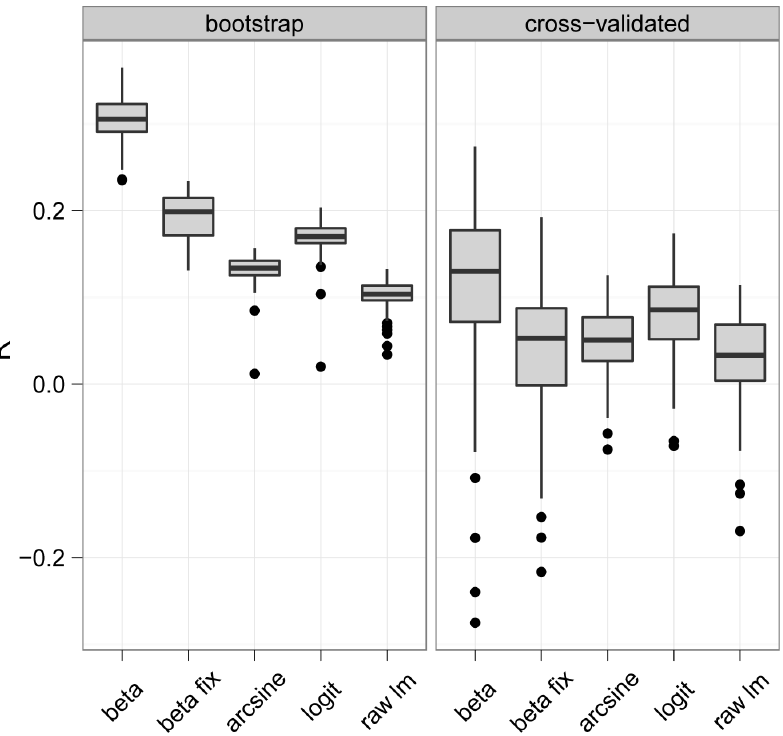
Figure 4. Boxplots of R 2 values. Analysis of the NLA Data. The figure contains boxplots of R 2 values obtained from the 100 bootstrap samples (left panel) and from the 100 sets of out-of-bootstrap observations (right